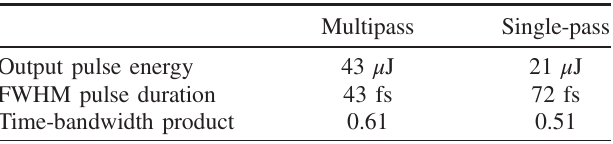
TABLE IV. Overview of 4.17 nm simulations. For the multi- pass HGHG the pulse energy and FWHM pulse duration are the average ones in the stable regime of the oscillator. The time- bandwidth product is calculated at the 65th